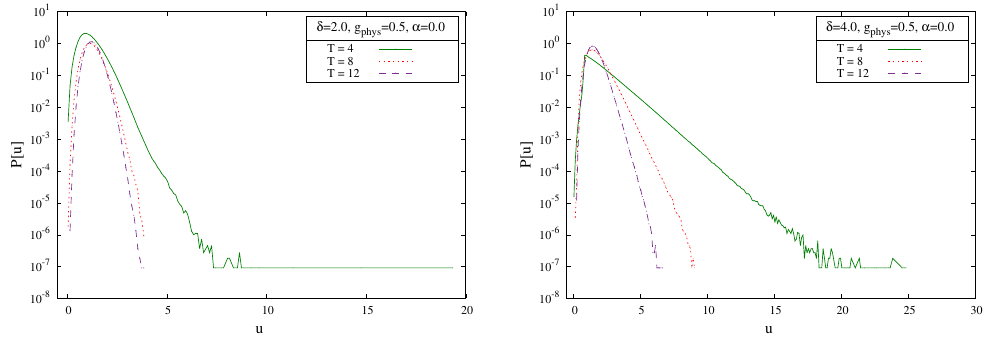
Figure 15 . Decay of the drift terms for the PT symmetric models with δ = 2 (left) and δ = 4 (right). The parameters used are g phys = 0 . 5 and α = 0 .